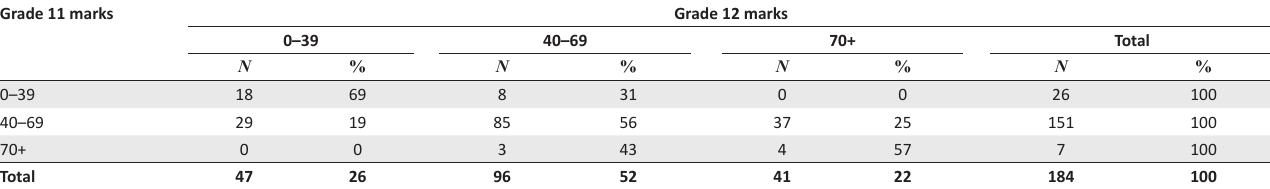
TABLE 4: Contingency table of Grade 11 and Grade 12 mathematics marks.